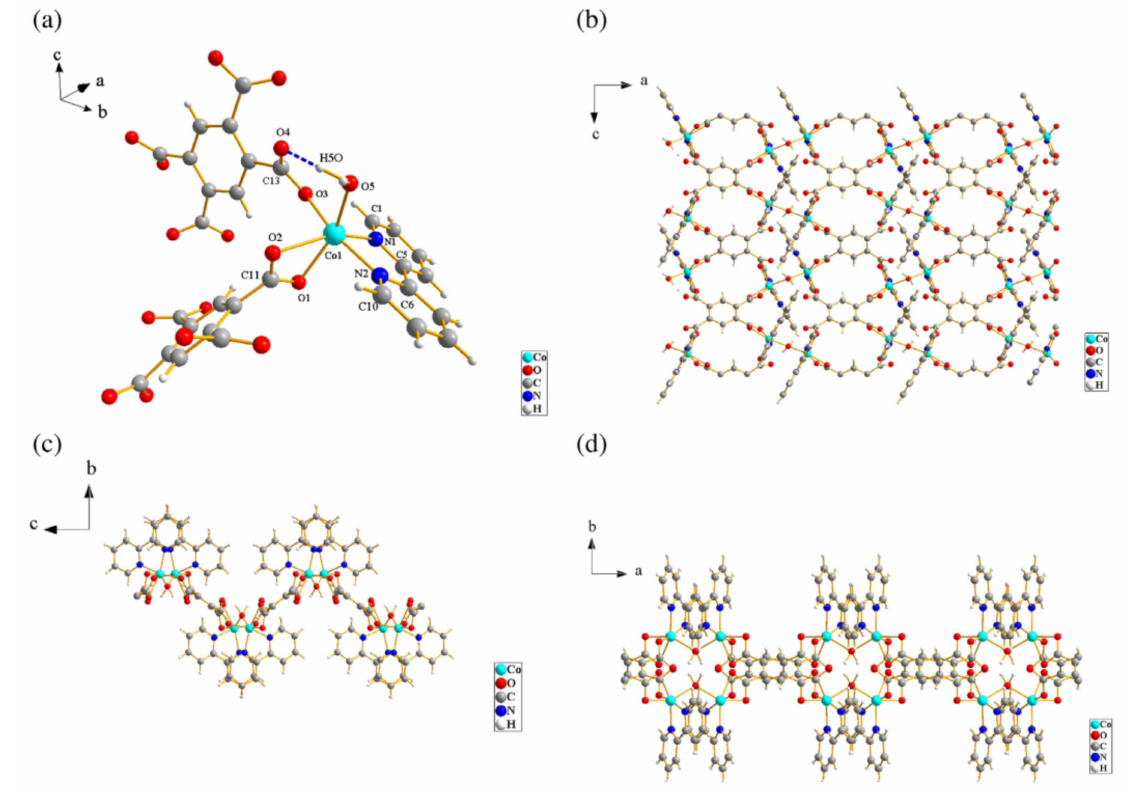
Figure 10. A ball and stick representation of {[Co 2 (-btec)(2,2 (cid:48) -bipy) 2 ]H 2 O} n structure: ( a ) The local coordination environment of the compound. The intra-chain hydrogen bonding interaction is shown in broken lines; ( b ) The network of the compound along the b axis; ( c ) The network of the compound along the a axis; ( d ) The network of the compound along the c axis. Reproduced with permission from [50].